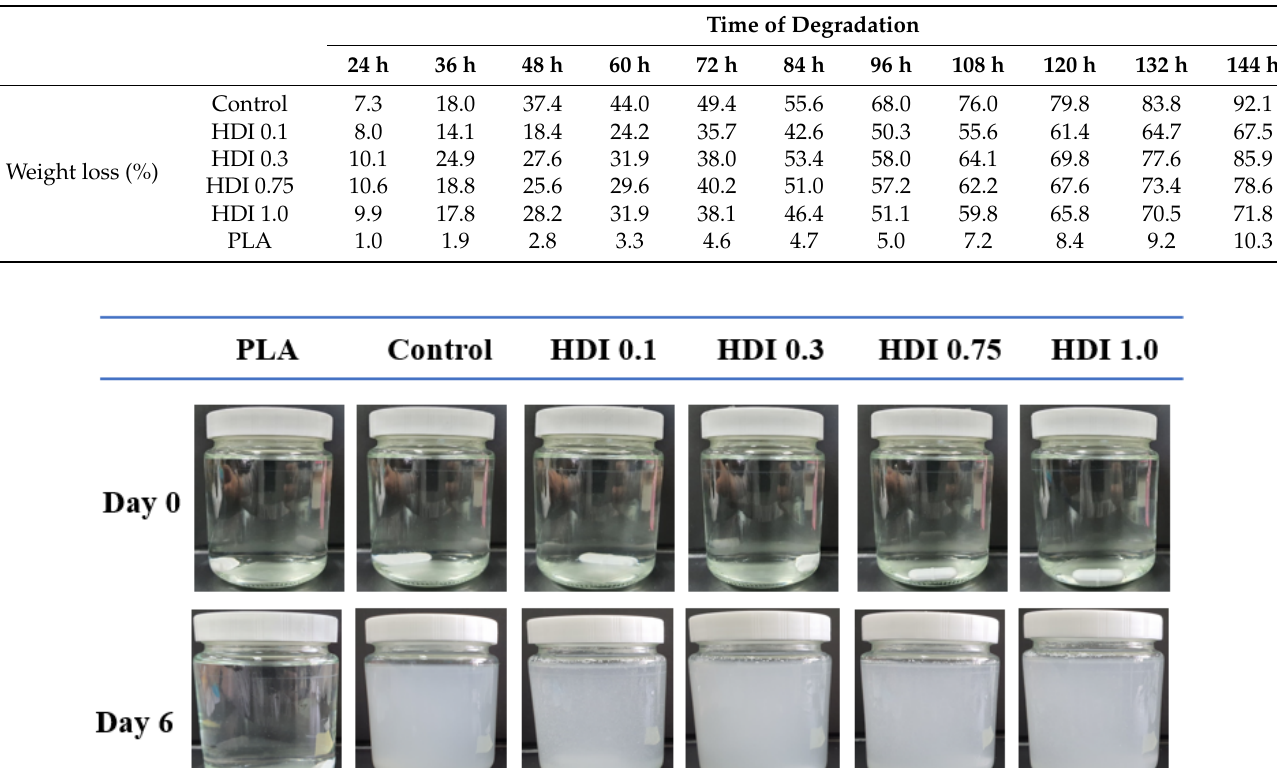
Table 6. Weight ‐ loss ‐ based degradation ratios determined for neat PLA, control, and blend specimens prepared with various HDI contents all hydrolytically degraded in NaOH.